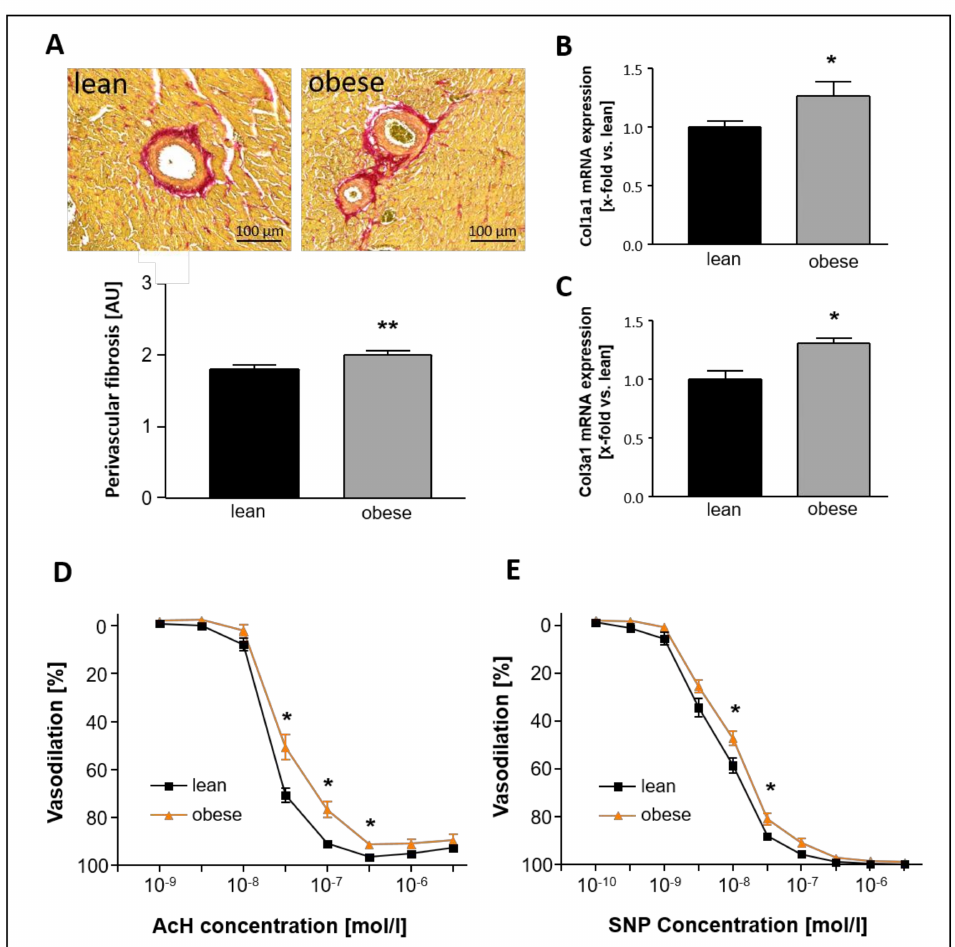
Figure 1. Baseline characterization of 20-week-old lean and obese Zucker fatty and spontaneously hypertensive (ZSF1) rats—myocardial fibrosis and vasodilative properties. ( A ) Brightfield microscopy of perivascular fibrosis in representative picrosirius-stained heart sections. ( B , C ) mRNA expression of Col1a1 ( B ) and Col3a1 ( C ) in LV tissue. ( D ) Endothelial-dependent vasodilation of sections of left carotid arteries in response to increasing concentrations of acetylcholine (AcH). ( E ) Endothelial- independent vasodilation of sections of left carotid arteries in response to increasing concentrations of sodium nitroprusside (SNP). Myocardial fibrosis: n = 10 for each group. Vascular function: n = 15 (lean and obese, respectively) and n = 13 (Sac/Val). Lean- and obese animals were compared by 2-sided Student’s t -test of equal variances. * p < 0.05, ** p < 0.01 vs. lean,